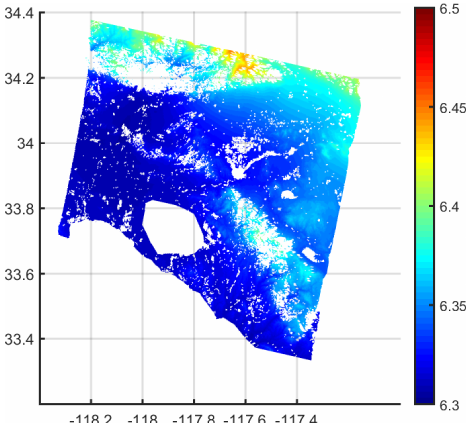
Figure 4. The spatial distribution of conversion factor (cid:53) calculated based on ERA-Interim. It is calculated at the time 18:00UTC on 16 August 2008.